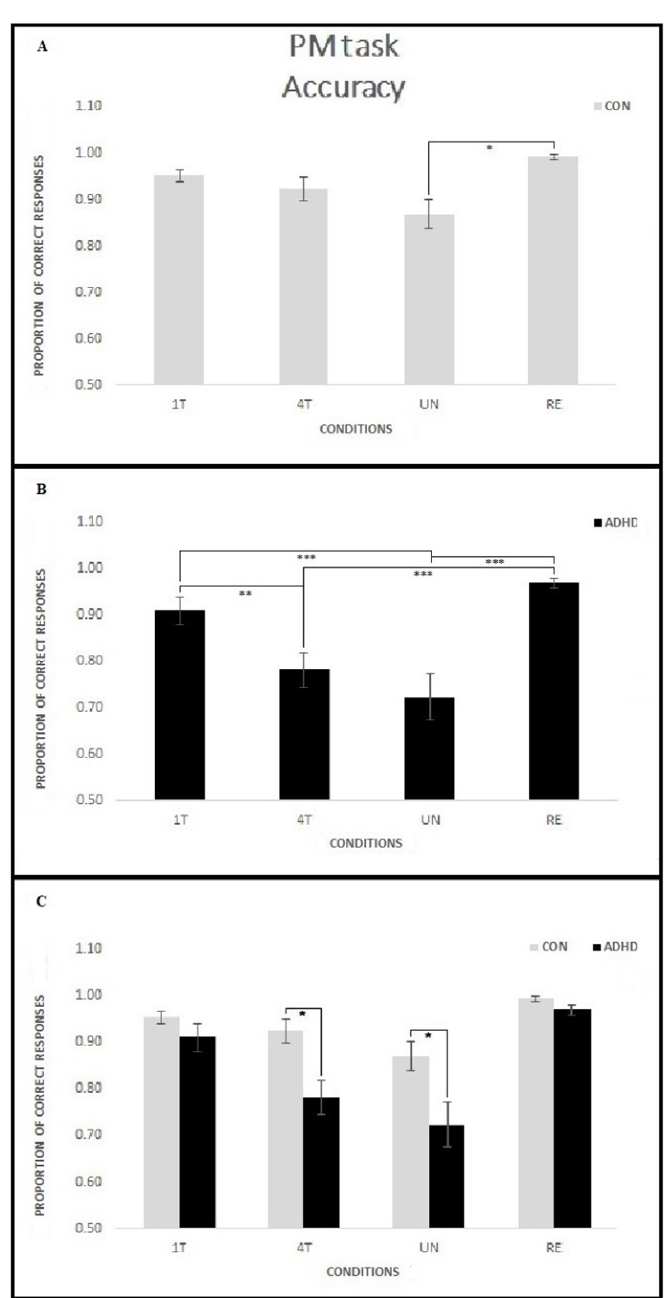
Figure 8. Accuracy on the PM trials for each PM condition in the two groups. Participants in the CON group showed no significant differences between conditions, with the exception of the UN, lower than the RE condition ( A ). Conversely, participants in the ADHD group showed lower accuracy on the 4T and UN conditions compared to 1T and RE ( B ). Moreover, differences between groups emerged because the ADHD group performed significantly lower than the CON group on the 4T and UN conditions ( C ). Asterisks mark significant differences: * p < 0.05, ** p < 0.01, *** p <